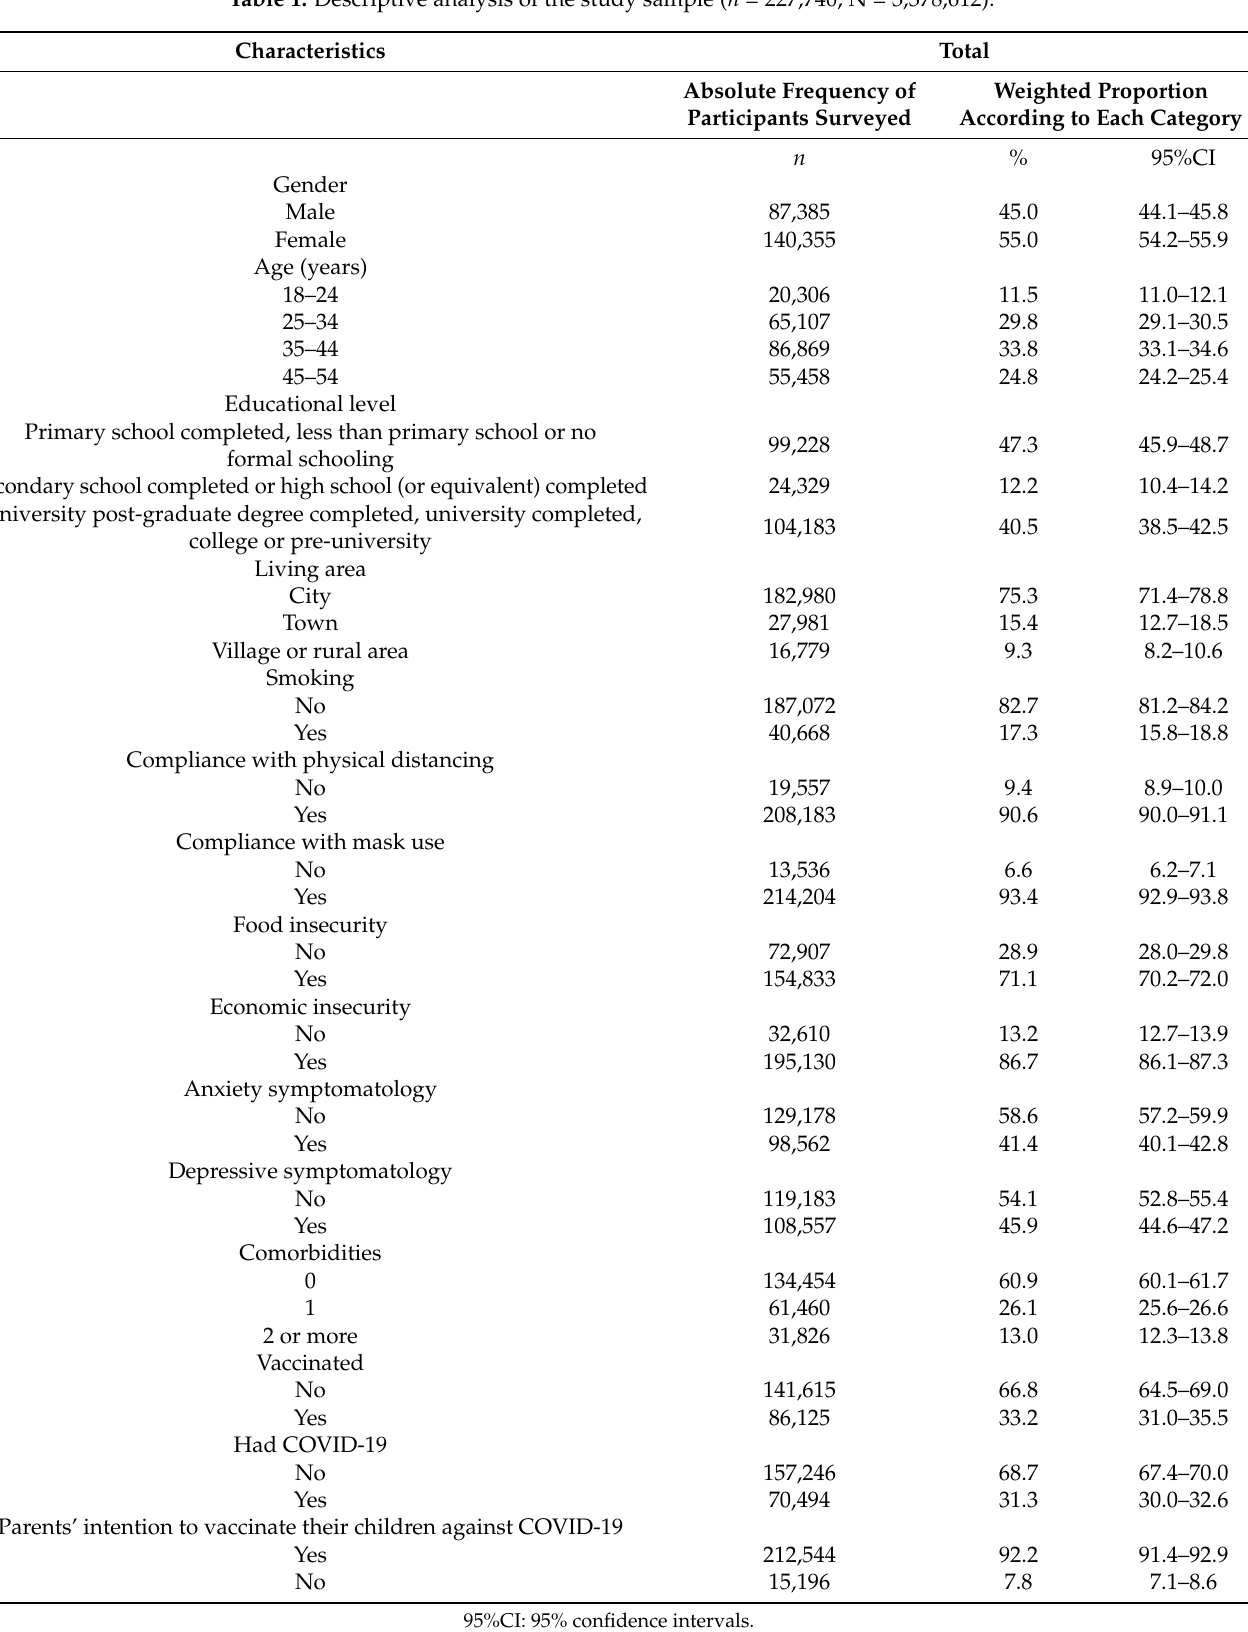
Table 1. Descriptive analysis of the study sample ( n = 227,740; N =